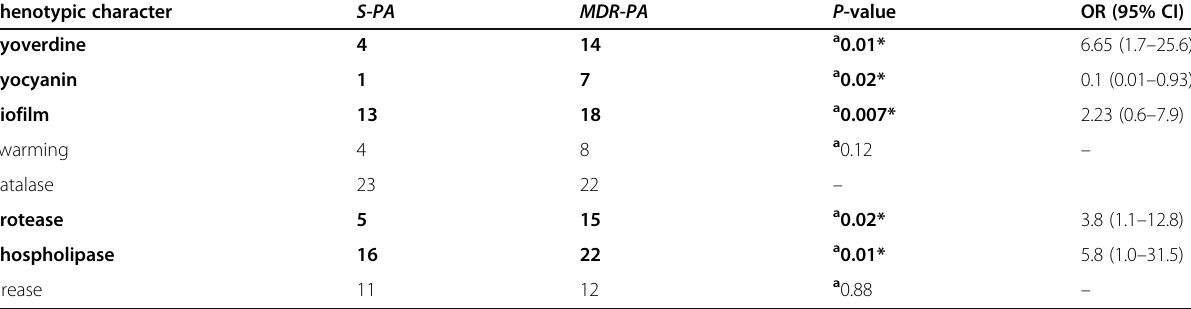
Table 2 Frequency and Statistical correlation of different virulence factors among Resistant and susceptible P. aeruginosa strains Phenotypic character